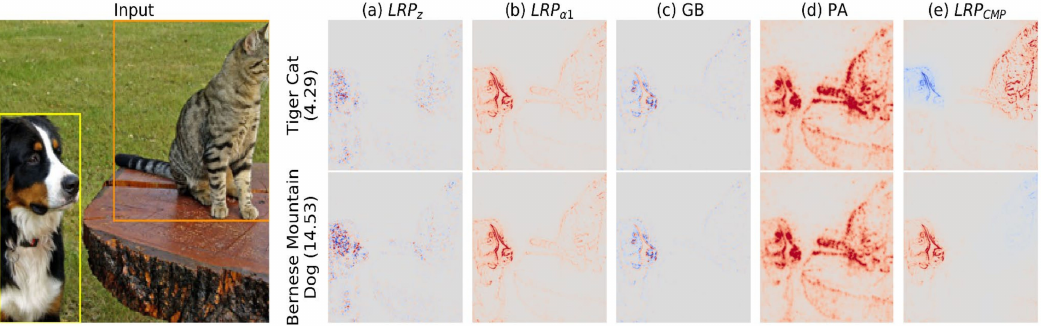
Figure 4. Heatmaps yielded by different techniques for two animals identified in a picture. Adapted with permission from [55],